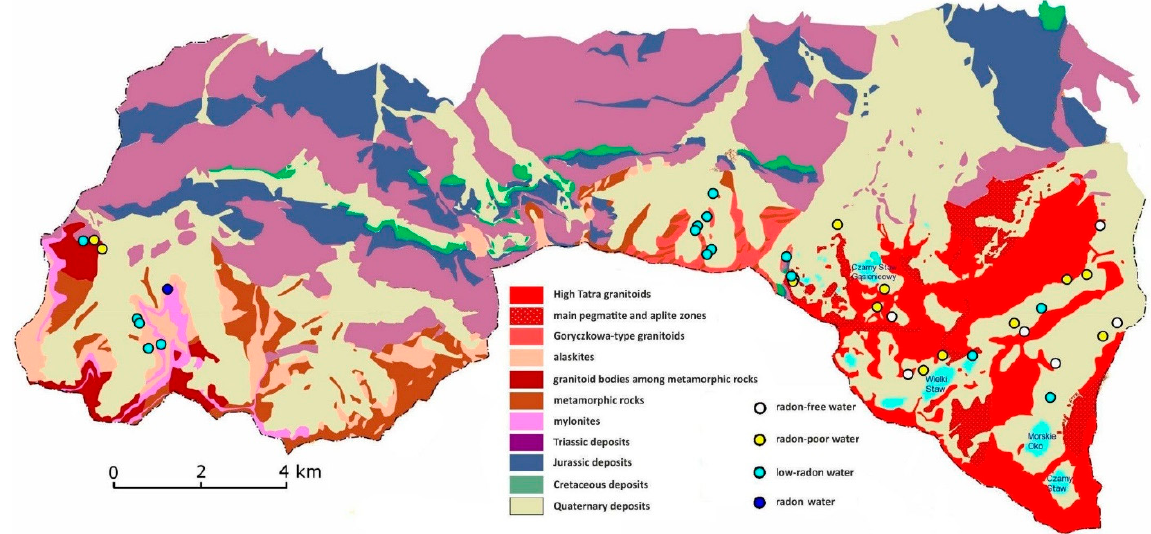
Figure 5. The Tatra granitoids. Groundwater sampling sites plotted together with the types of collected water by 222 Rn content according to Przylibski’s classification